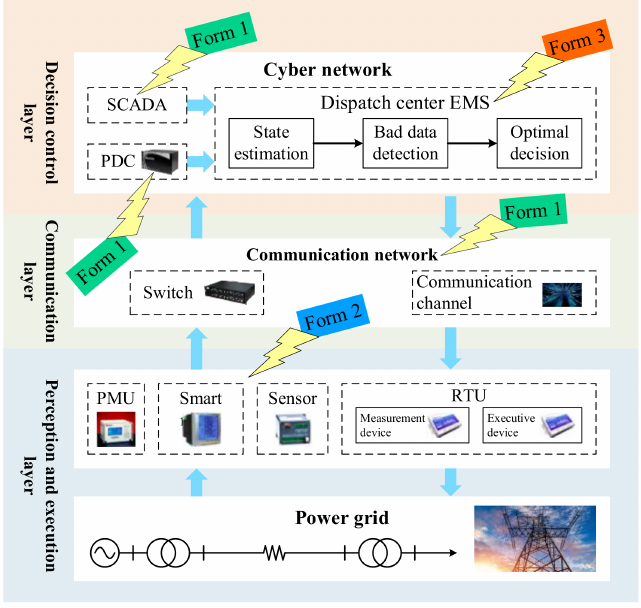
Figure 2. Data transmission scenario and false data injection forms of power